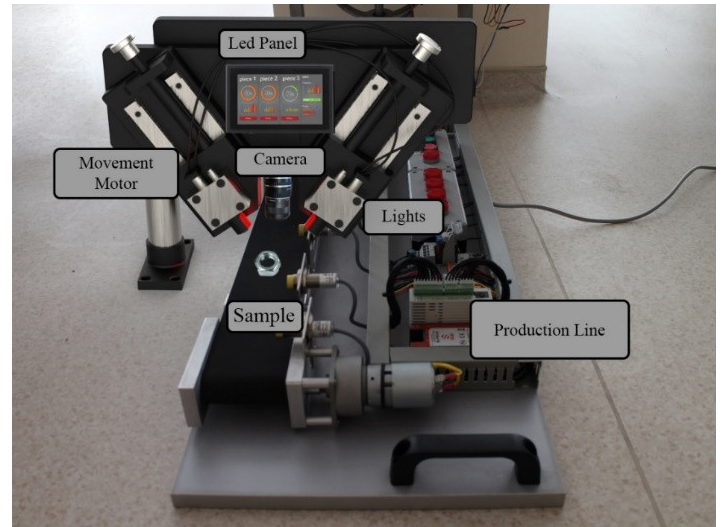
Figure 6. Original system.